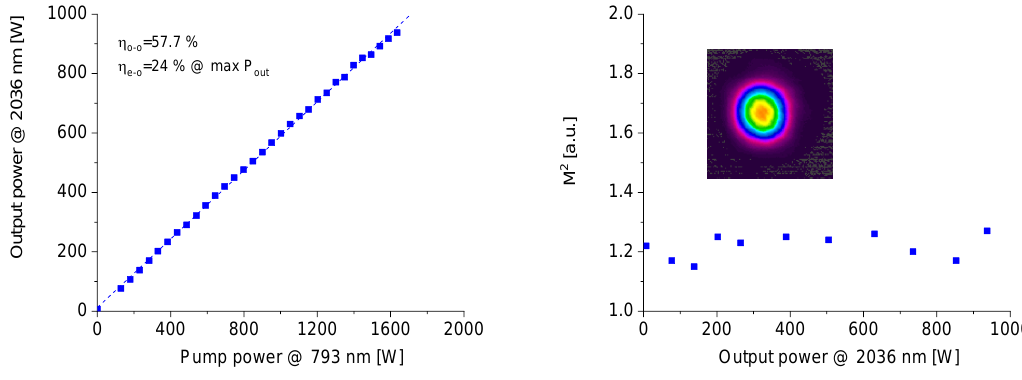
Figure 1: MOPA laser output power versus 793 nm pump power at an emission wavelength of 2036